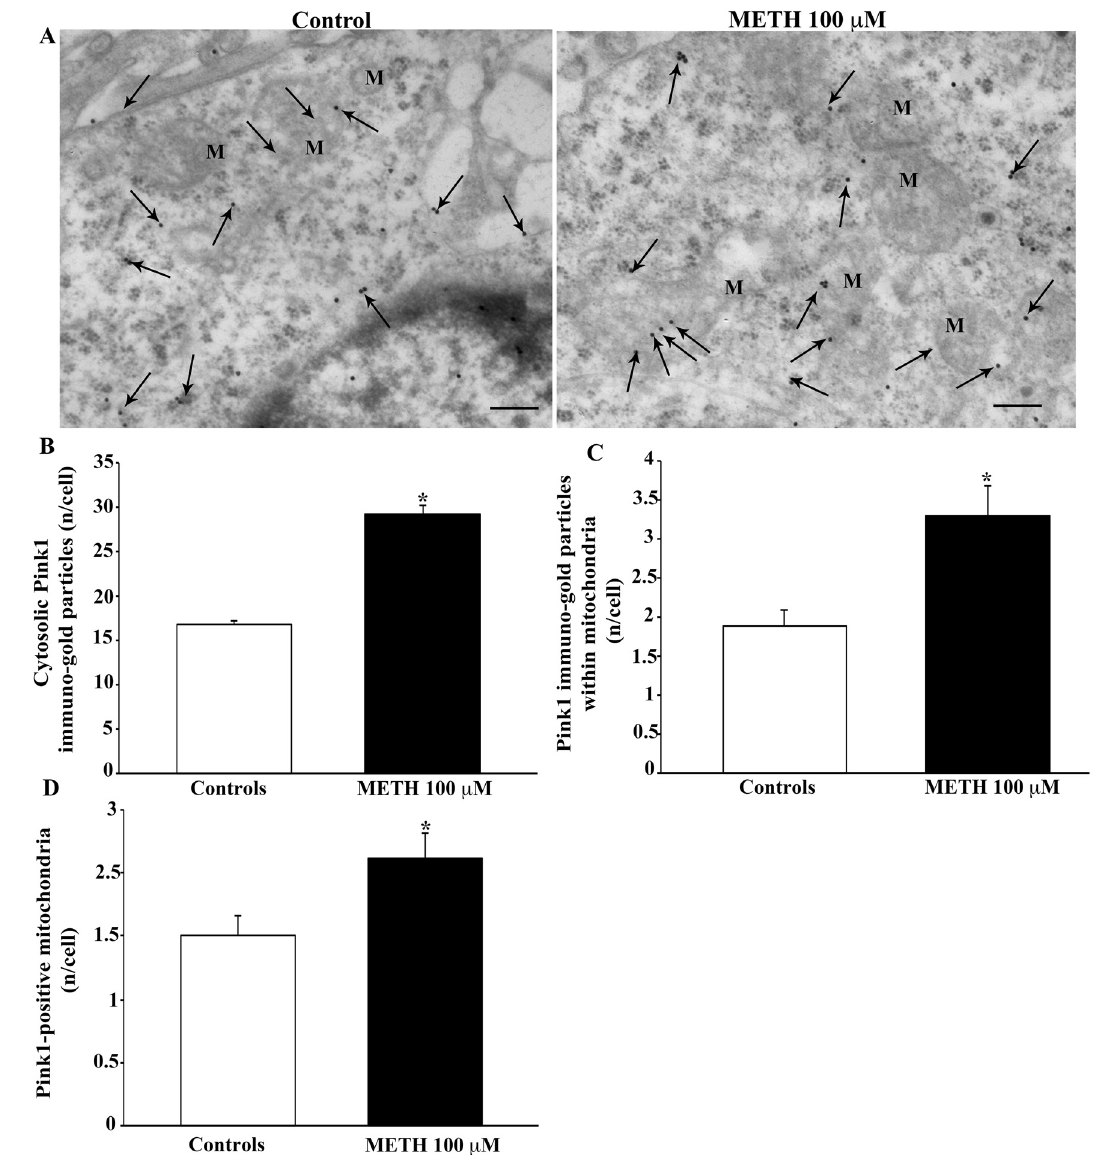
Figure 15. METH increases the protein, Pink1. ( A ) Representative TEM micrographs showing Pink1 particles from control and following METH 100 μ M. Arrows point to Pink1 immunogold particles within cytosol and mitochondria (M). Graph ( B ) reports the number of Pink1 immunogold particles within the cytosol. Graph ( C ) reports the number of Pink1 immunogold particles within mitochon- dria. Graph ( D ) indicates the number of Pink1-positive mitochondria. Values are given as the mean ± S.E.M from N = 50 cells per group. * p ≤ 0.05 compared with controls. Scale bars = 170 μ m.